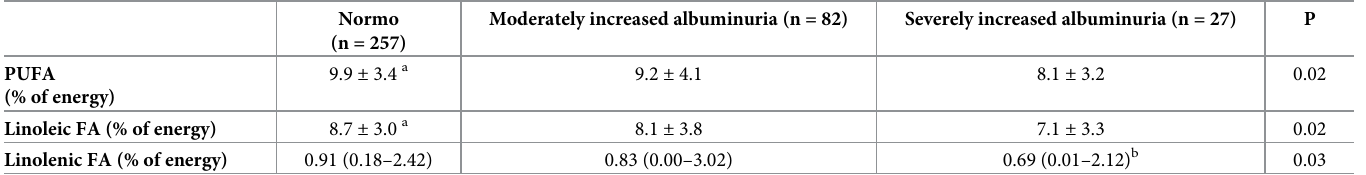
PUFA: polyunsaturated fatty acids a Normo vs Severely increased albuminuria b Normo and moderately increased albuminuria vs severely increased albuminuria. Data are expressed as mean and standard deviation, or median and interquartile